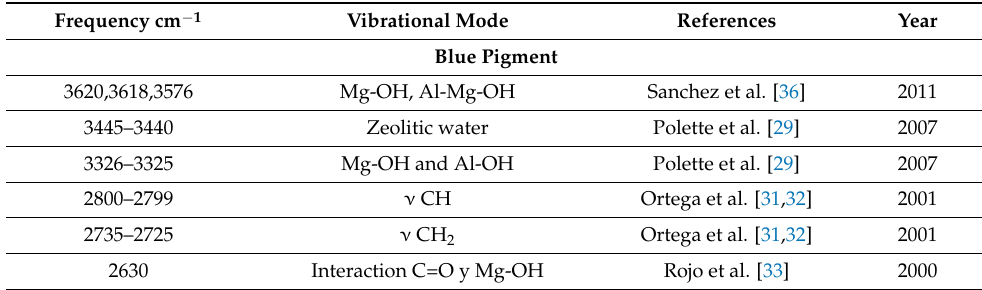
Figure 10. Infrared absorption spectra of pigments: ( a ) M1 blue, ( b ) M2 blue, ( c ) ochre, and ( d ) red. Table 5. Infrared absorption frequencies of the